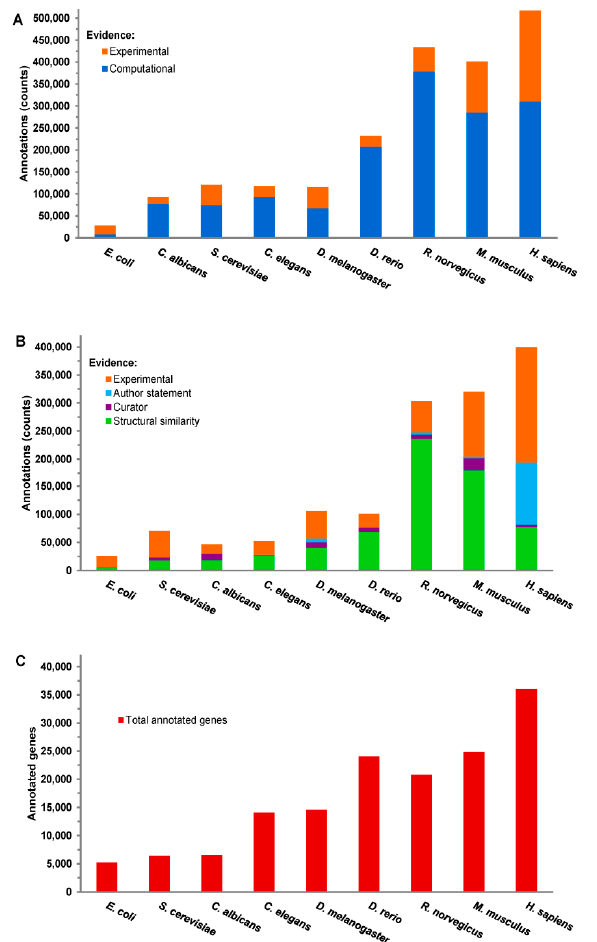
Figure 6. ( A ) Gene annotations in Gene Ontology (GO) across species based on type of evidence supporting gene annotation. ( B ) Breakdown of gene annotations based on most frequently used evidence categories (Biological Process, Cellular Component, and Molecular Function categories combined). ( C ) Number of genes annotated with at least one GO term in the species.